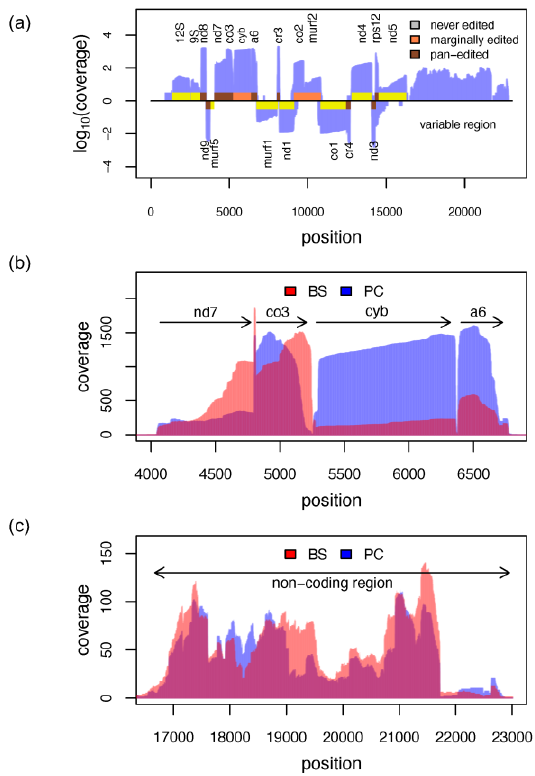
Figure 8. Mitochondrial gene expression. ( a ) Linear map of both strands of the T. brucei mitochondrial (maxicircle) genome overlayed with the coverage profile of procyclic-stage trypanosomes (blue). Gene abbreviations are as in [58]. Never-edited genes are in yellow, marginally edited genes in orange, and pan-edited genes in pink. ( b ) Overlay of the coverage profiles from bloodstream-stage (BS, red) and procyclic-stage (PC, blue) trypanosomes in the coding region from ND7 to A6. ND7 = subunit 7 of the NADH dehydrogenase. CO3 = cytochrome oxidase subunit 3. Cyb = cytochrome b. A6 = subunit 6 of the mitochondrial ATPase. ( c ) Overlay of the coverage profiles from bloodstream-stage (BS, red) and procyclic-stage (PC, blue) trypanosomes in the non-coding (variable) region of the T. brucei maxicircle genome.